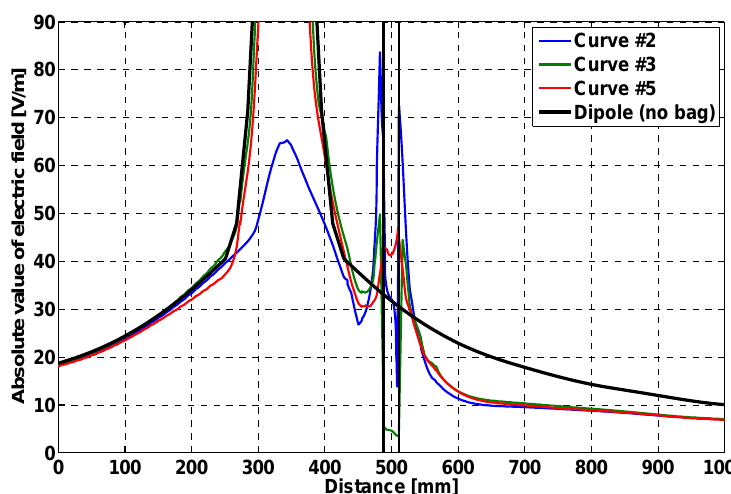
Figure 7. Field due to a dipole located at 15 cm from the bag side. The curve number refers to the segments in Figure 2. The curve labeled “Dipole (no bag)” shows, for comparison, the free-space dipole field comparison.